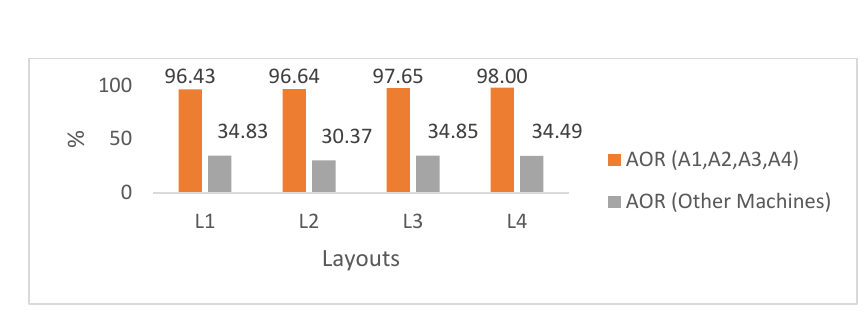
Figure 12. Average occupancy rate (AOR).